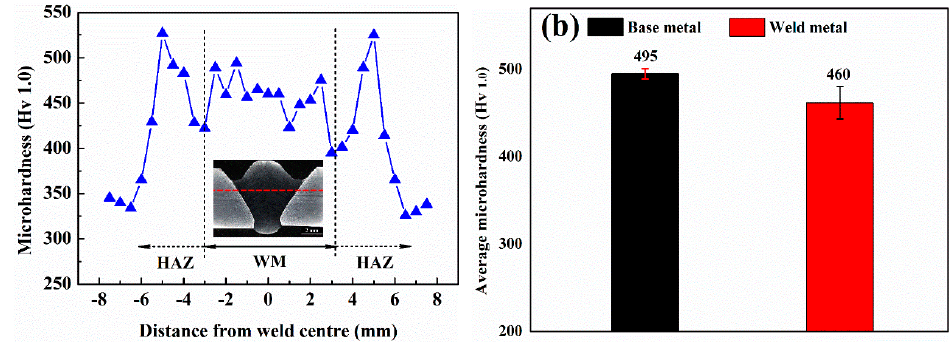
Figure 10. Hardness results; ( a ) Hardness distribution across weld; and ( b ) Average hardness for base metal and weld metal.